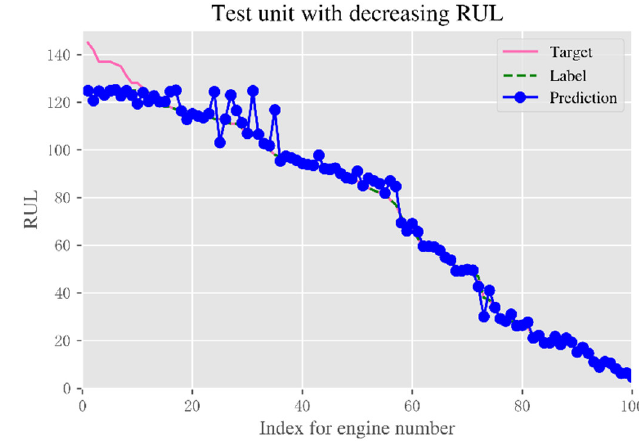
Figure 10. RUL prediction results for 100 engines.